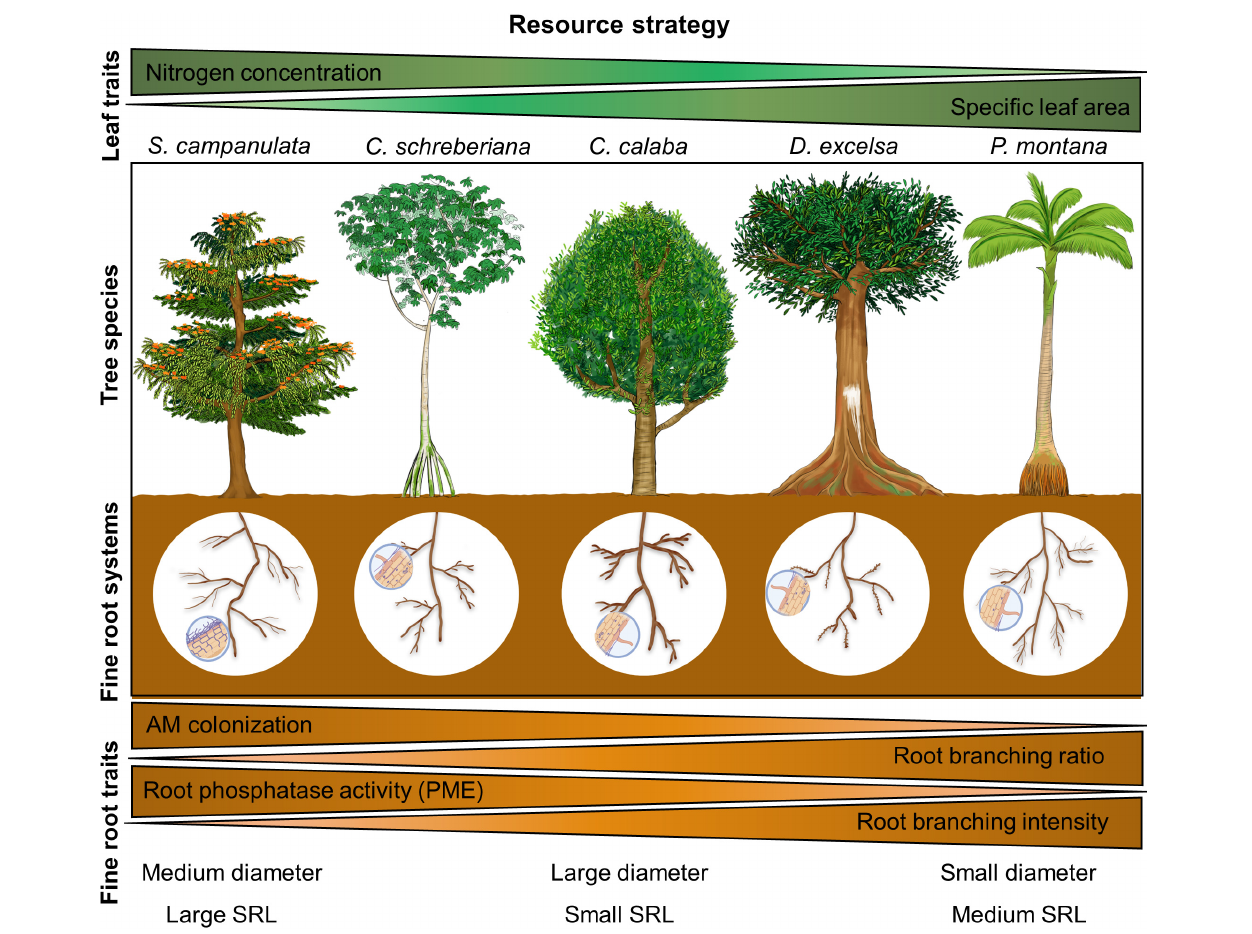
FIGURE 6 | Conceptual diagram of belowground phosphorus-acquisition strategies of five tropical tree species from Puerto Rico. Our results highlight a trade-off between highly colonized fine roots with high phosphatase activity and fine roots that have a high degree of branching. Furthermore, the former strategy is adopted by pioneer species ( Spathodea campanulata and Cecropia schreberiana ), whereas the latter is adopted by non-pioneer species (mostly Dacryodes excelsa and Prestoea montana ). Root phosphorus concentration was not included here because no clear pattern was found across